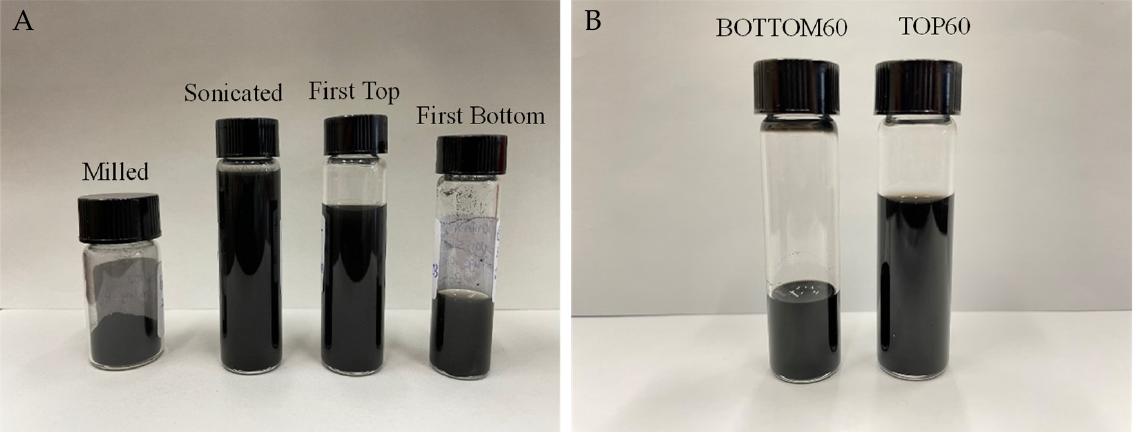
Figure 1. GNP samples, at the different steps of production: ( A ) Nanoparticles samples after milling, sonication, and first centrifugation steps (First Top and First Bottom). ( B ) Nanoparticles after second centrifugation (TOP60 and BOTTOM60). BOTTOM60 and TOP60 dispersion are stable in water.